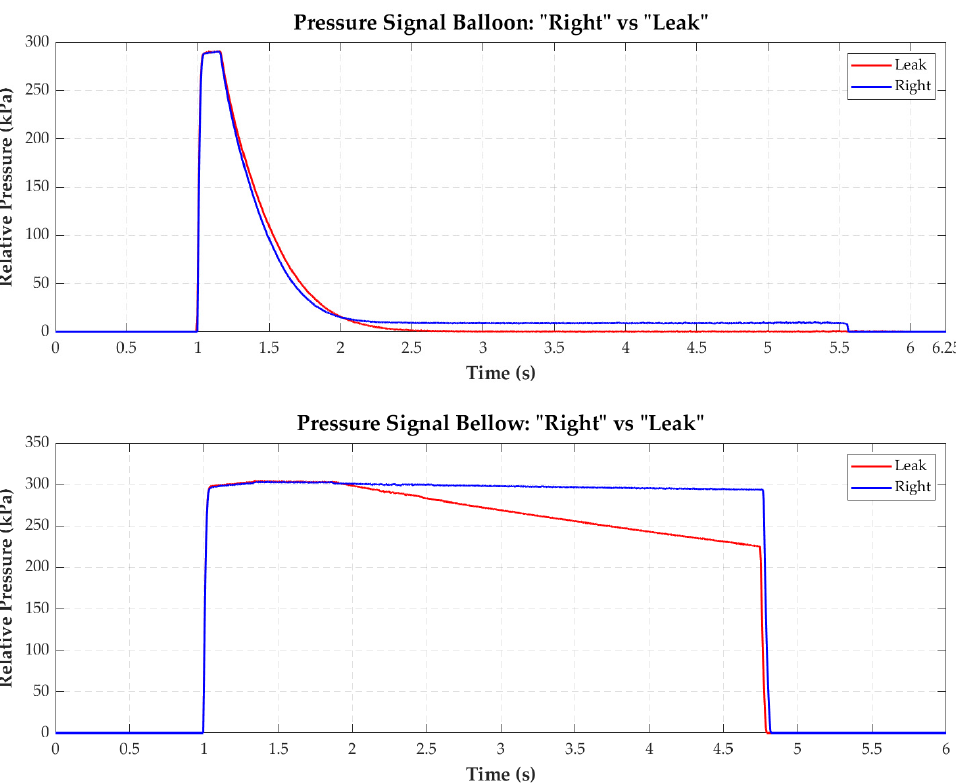
Figure 4. Representation of typical signals of the class “Right” (blue) and “Leak” (red) for the cavities balloon ( a ) and bellows ( b ).